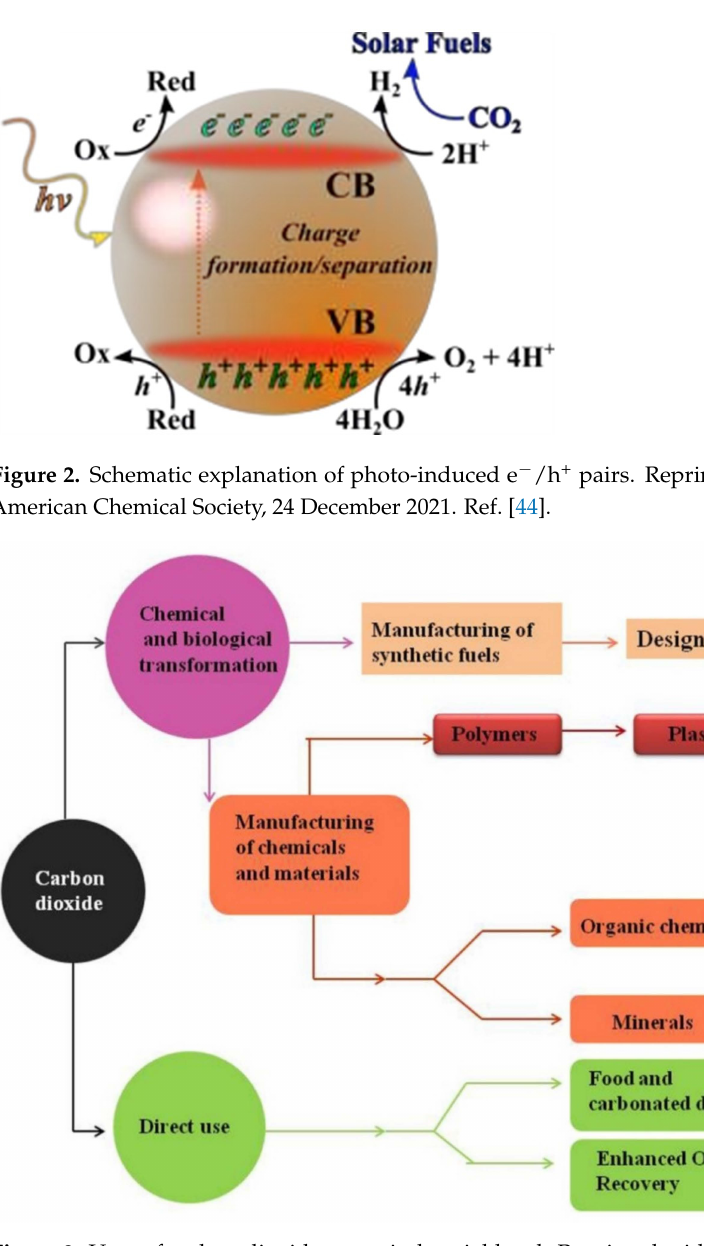
Figure 3. Uses of carbon dioxide on an industrial level. Reprinted with permission from Elsevier, 19 December 2021 Ref.